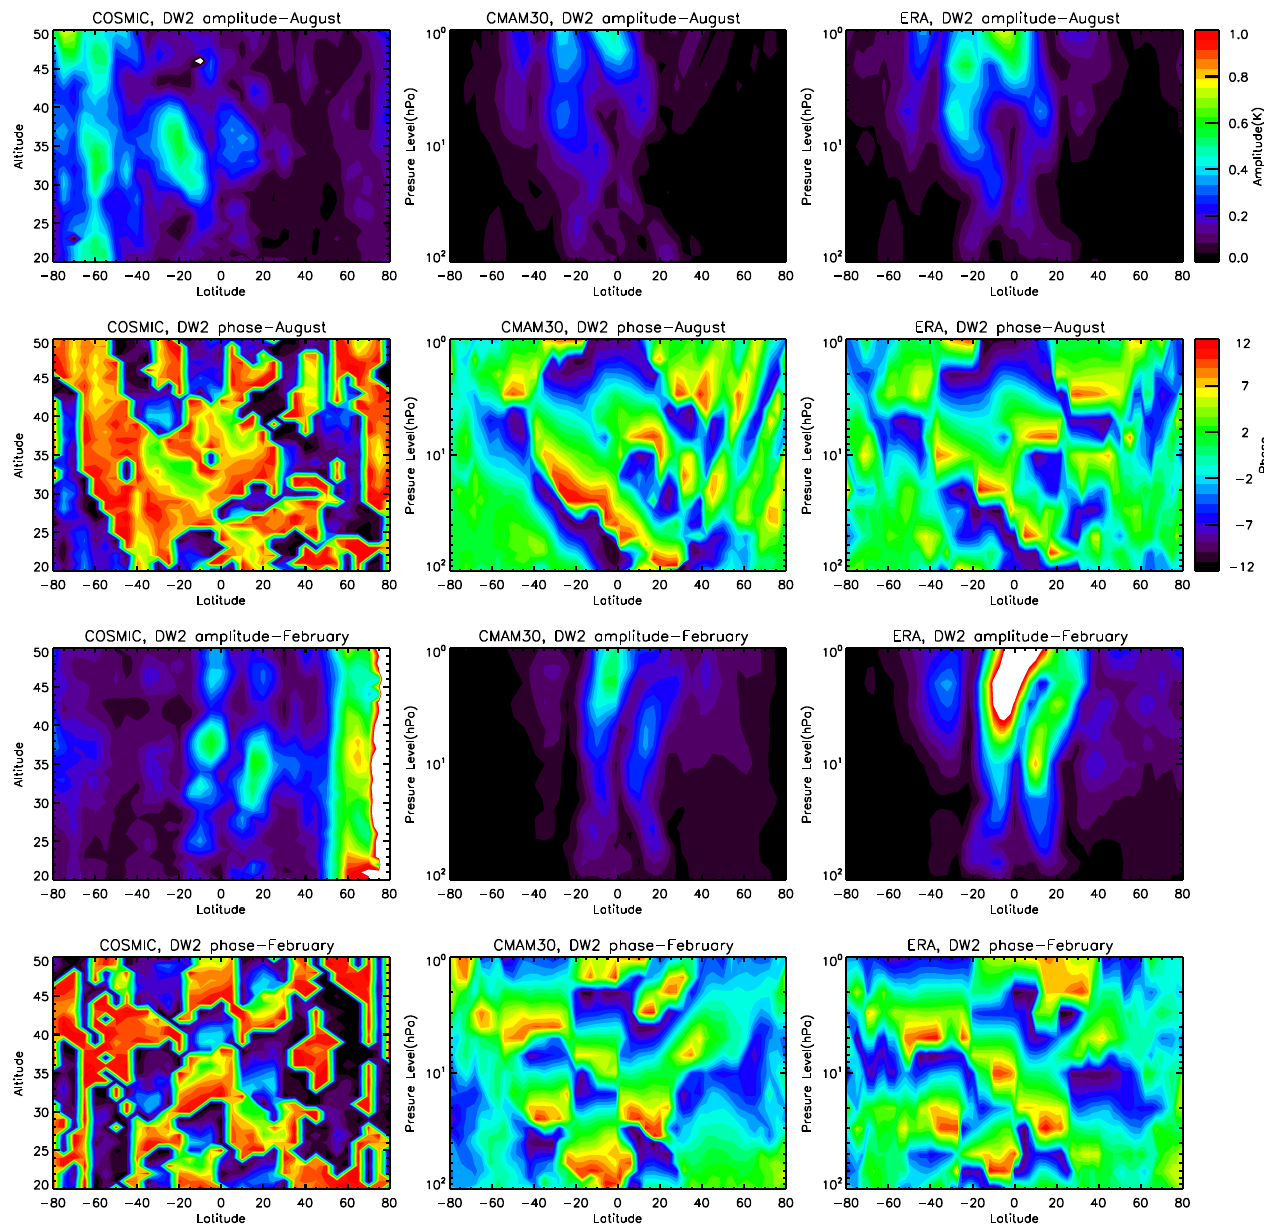
Figure 6. Altitude versus latitude cross-section of mean amplitude and phase of DW2 tide during August 2008 and February 2009 from COSMIC, CMAM30, and ERA-interim